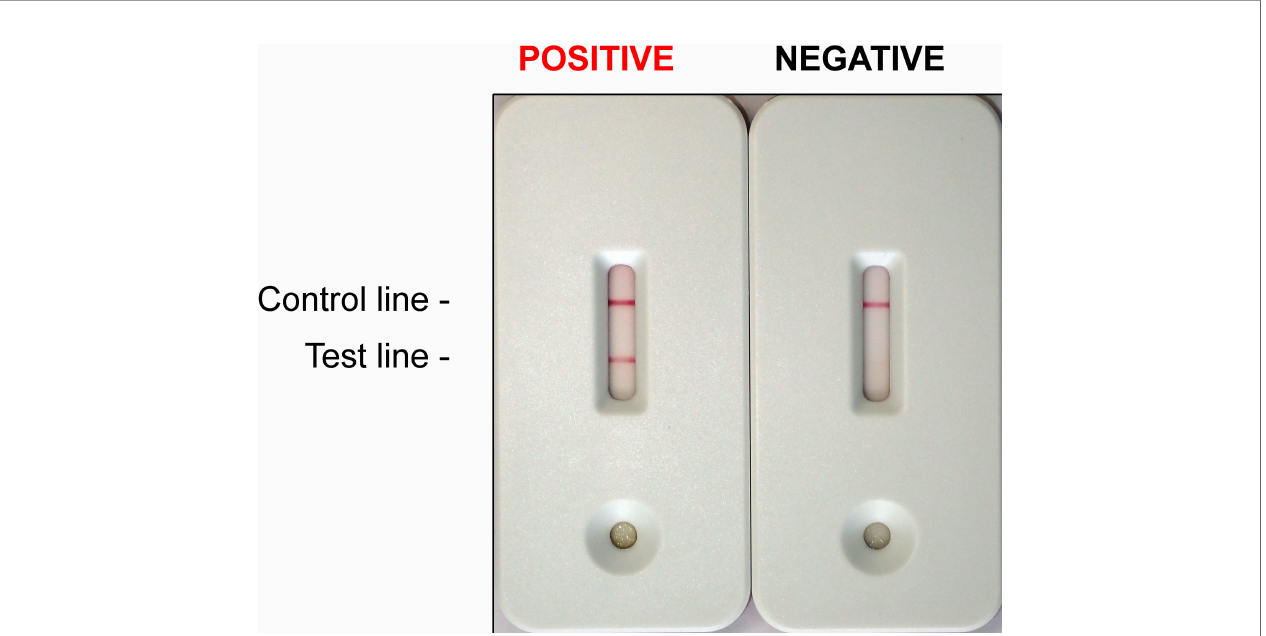
FIGURE 1 | Staphylococcus aureus Panton Valentine leukocidin Lateral Flow Immunoassay. A positive and a negative test. Lines must appear within 10 min of incubation at room temperature. Red lines appearing in the TEST line region (TEST) and in the CONTROL line region (CONTROL) indicate together a POSITIVE result (LEFT). The TEST line can be weaker than the CONTROL line. A red line appearing in the CONTROL line region (CONTROL) serves as the internal control. It con fi rms suf fi cient sample volume and correct procedural technique. If the CONTROL line was absent, the test is to be regarded as INVALID and should be repeated. A clear background is also required. If only the CONTROL line appears (RIGHT), the test is